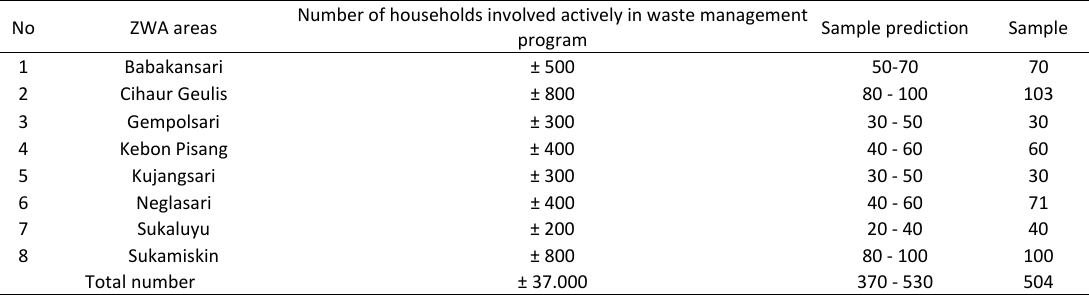
Table 1: The Number of population in ZWA areas and samples for survey